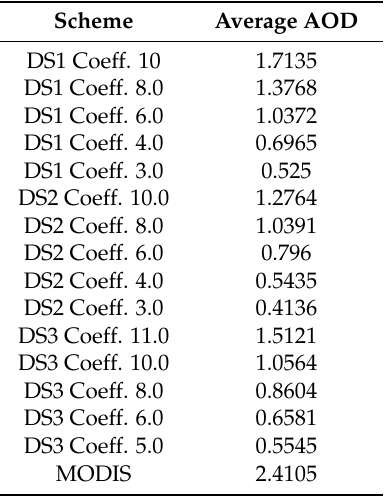
Table 10. Average AOD over domain D2 from using all the schemes with all coefficients, in addition to MODIS AOD at 550 nm wavelength the dust storm of Mrach